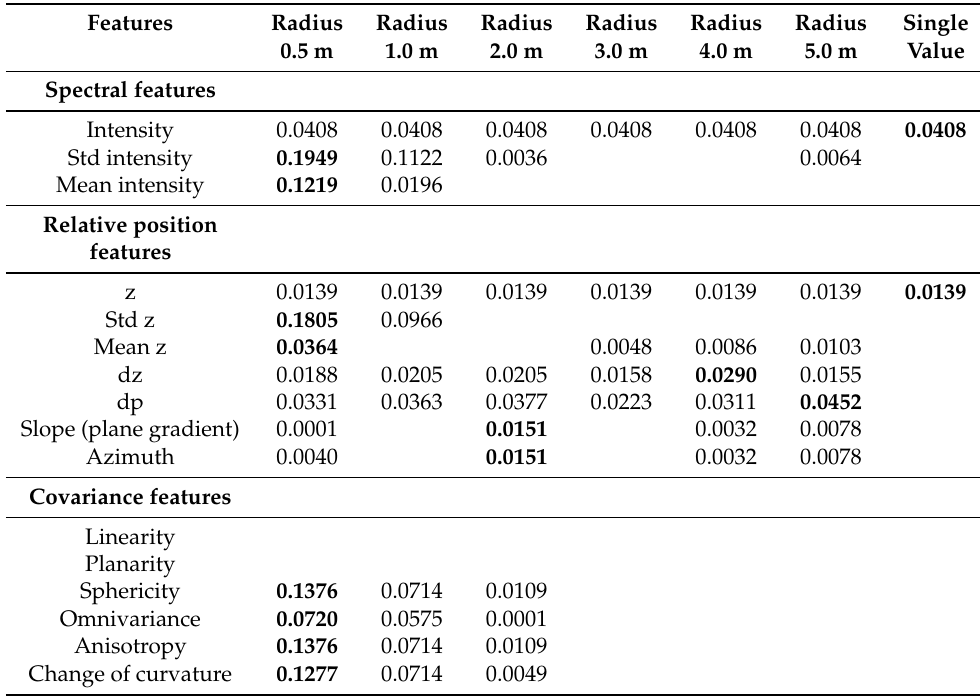
Table 6. Boulder 4 predictors with positive weight calculated from relief-F